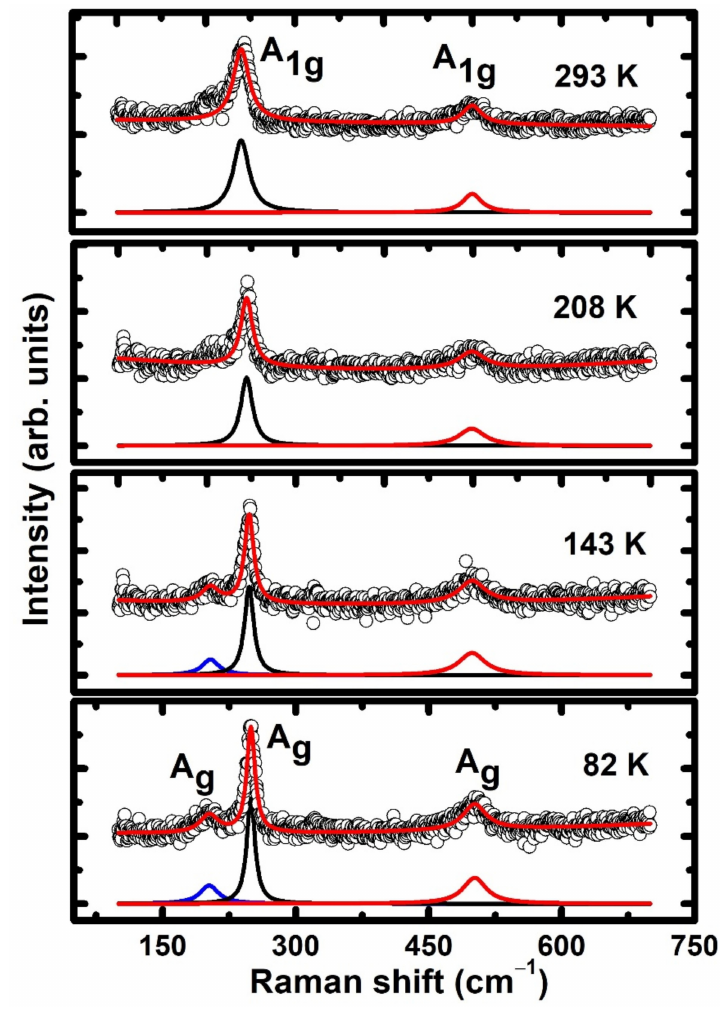
Figure 8. Raman spectra recorded at different temperatures. The total fitted and individual compo- nents of the spectrum are also shown